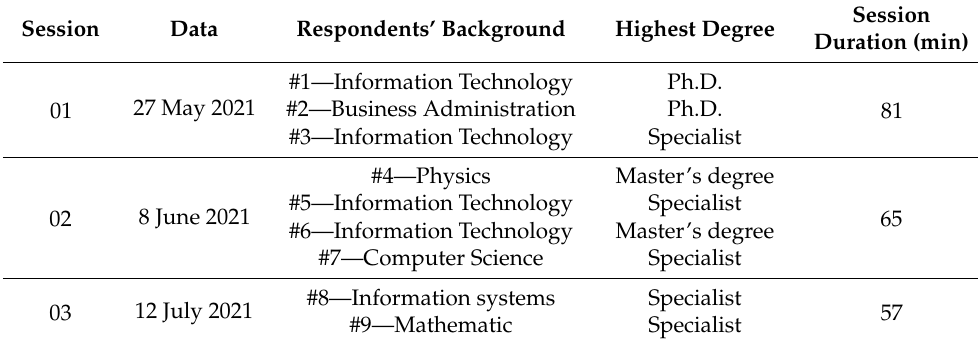
Table 3. Data from the interviews in the focus